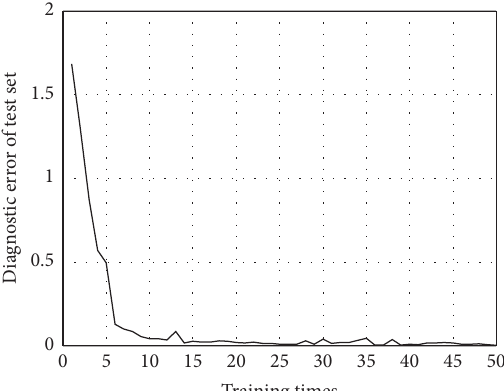
Figure 9: Influence of training time on diagnosis error.